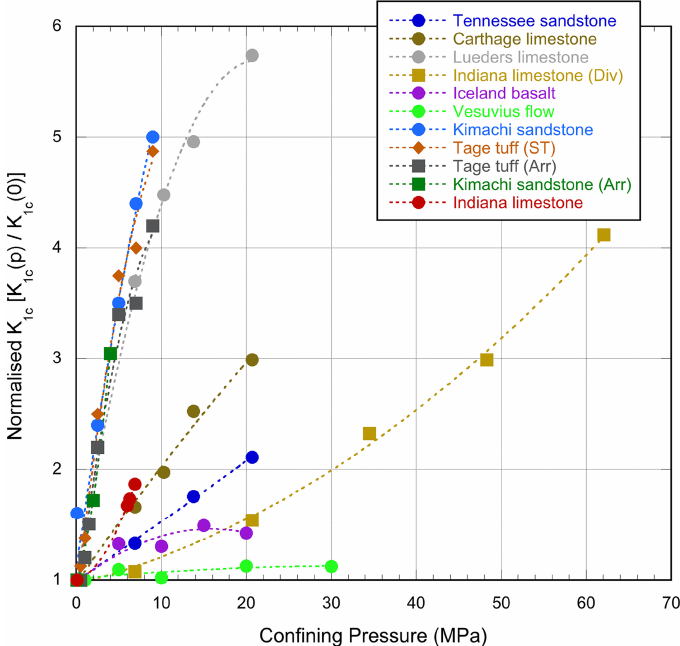
Figure 3. The influence of confining pressure on the normalized K Ic for rocks. ( K Ic (0): the K Ic measured at ambient pressure). Reprinted with permission from Ref. [78]. Copyright 2020, John Wiley and Sons.